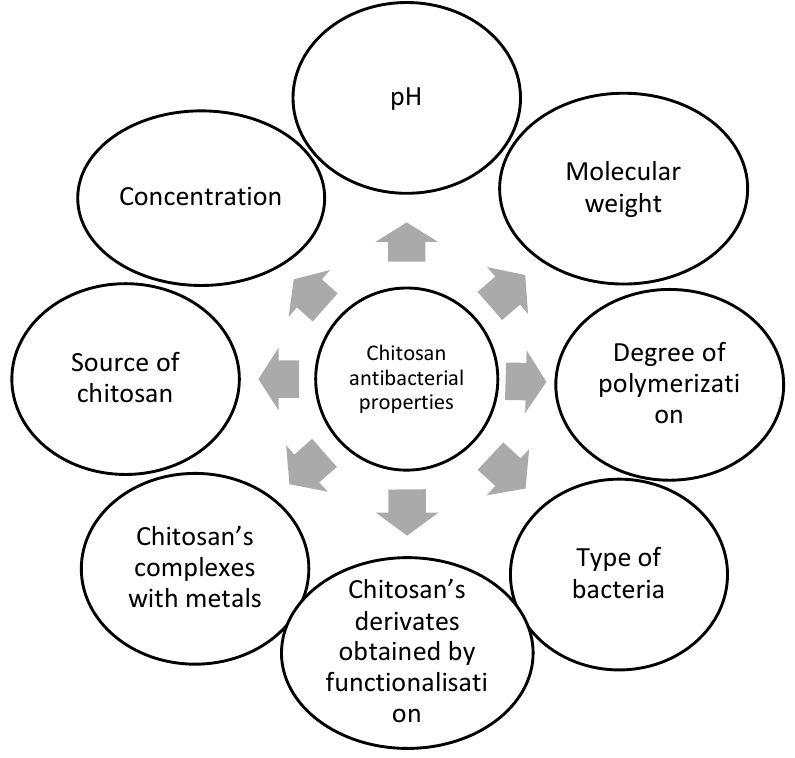
Figure 5. Intrinsic and external factors contributing to chitosan’s antibacterial activity.